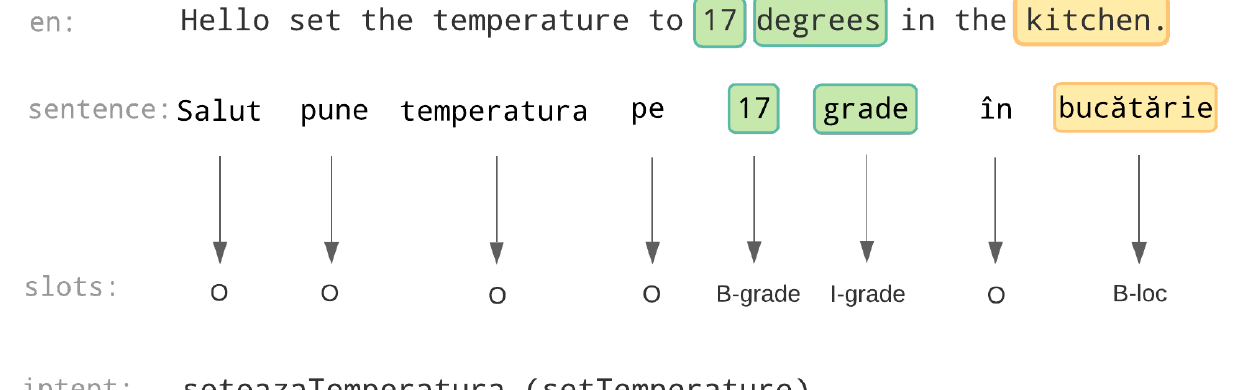
Figure 1. Intent detection and slot filling. For the slot filling labels, we use the IOB labelling format [1]. The “B-” prefix indicates that the word is at the beginning of a slot, the “I-” prefix indicates that the word is on the inside or at the end of a slot (occurs when slots contain at least 2 words). The “O” label is assigned to words not belonging to any